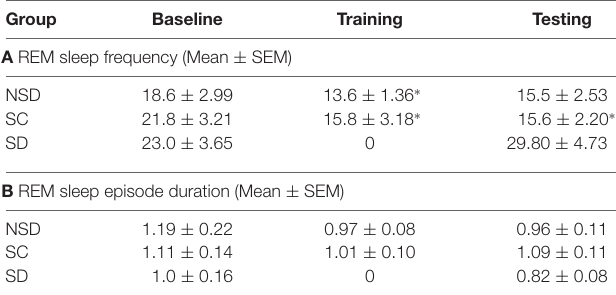
TABLE 1 | Rapid eye movement (REM) sleep episode numbers and duration in non-sleep deprived (NSD), stress control (SC) and sleep-deprived (SD) mice on the baseline, training and testing days of contextual fear